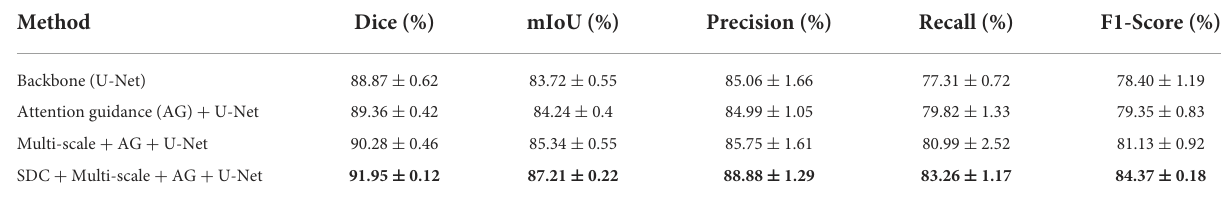
TABLE 3 Ablation study for each component of our model for thyroid nodule segmentation on the TNUI-2021 dataset. The average of 5-fold cross-validation ±